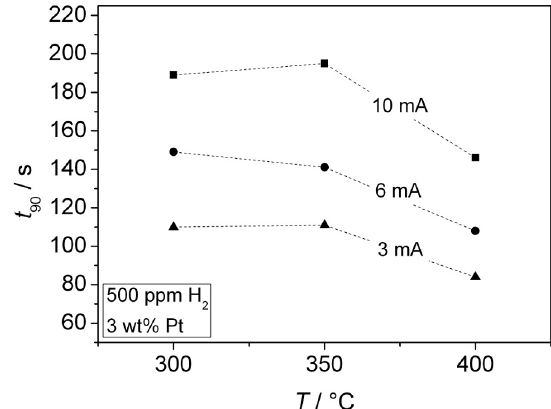
O film thickness. 2 3